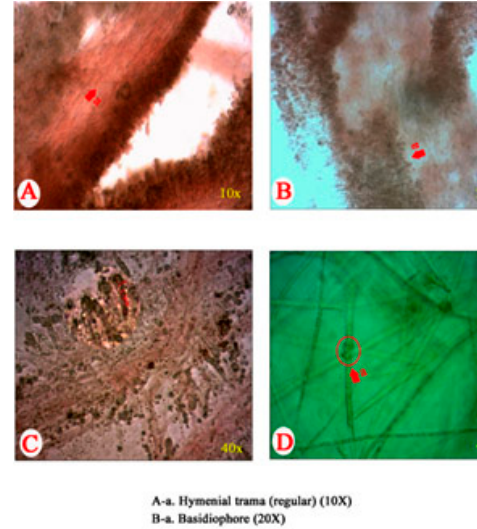
Fig. 3d. Microscopic observation of Macrocybe gigantea (Massee)